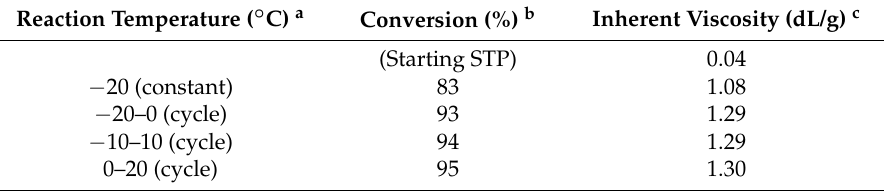
Table 1. Conversion of silanol end groups and viscosity of reaction products in the condensation reaction of STP in the presence of